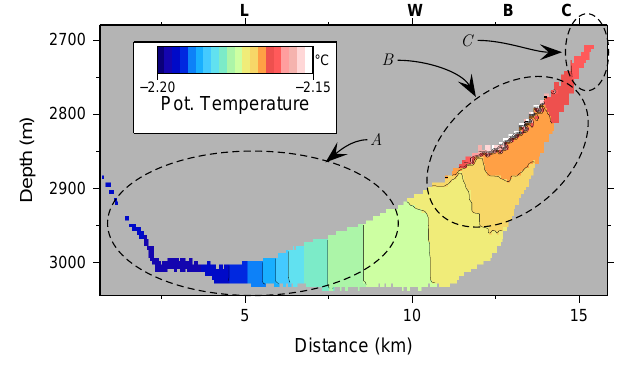
Fig.3. TemperaturecrosssectionalongthepathshowninFigure2. Differenttemperatureregimesareindicatedbyblack-dashed ovals, Approximatelakeaccesspointslocations(seetext)alongthiscrosssectionareindicatedontop. Fig. 3. Temperature cross section along the path shown in Fig. 2. Different temperature regimes are indicated by black-dashed ovals, Approximate lake access points locations (see text) along this cross section are indicated on